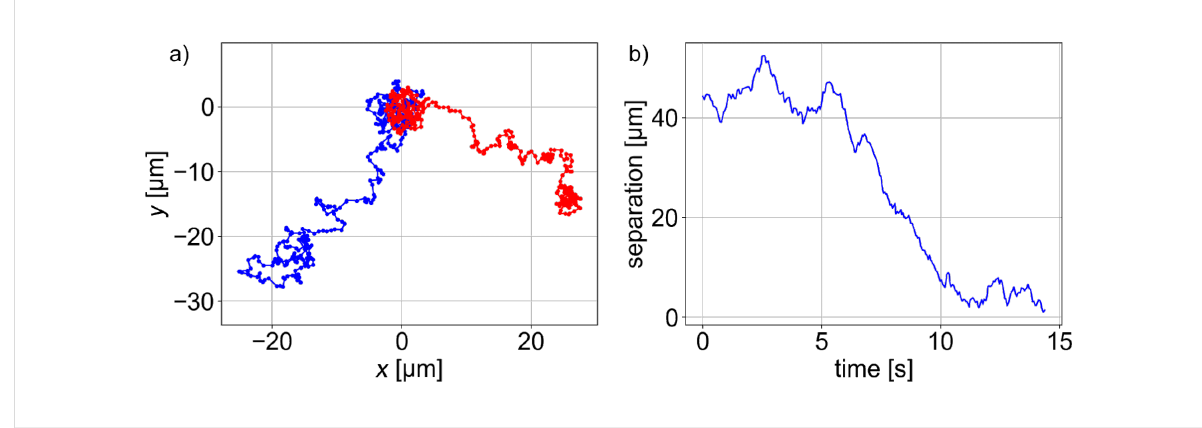
Figure 6: Independent manipulation of two 200 nm particles in water. (a) Particle trajectories. (b) Time dependence of interparticle separation.